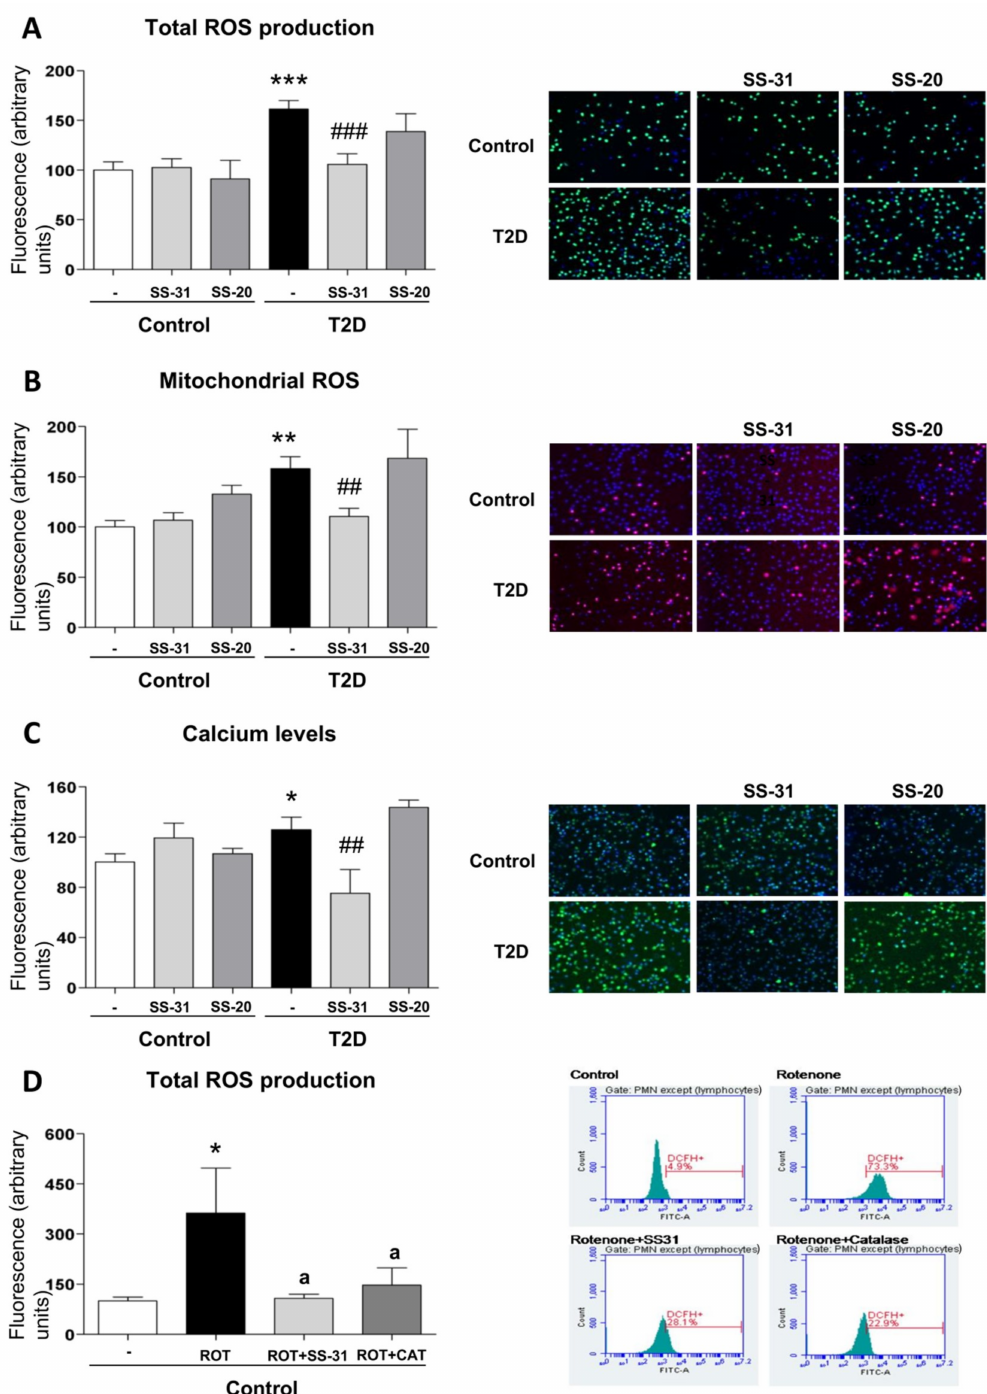
Figure 1. E ff ects of Szeto–Schiller (SS)-31 (30 min, 100 nM) on total and mitochondrial ROS production, and calcium levels in leukocytes from type 2 diabetes (T2D) patients and healthy subjects. ( A ) reactive oxygen species (ROS) production, measured as deacetylated by endogenous hydrolases to a form (DCFH)-DA fluorescence. ( B ) Mitochondrial ROS production, assessed as MitoSOX fluorescence. ( C ) Calcium levels, determined as Fluo-4 fluorescence. Representative fluorescence microscopy images are also shown. ( D ) Analysis of total ROS levels, measured as DCFH-DA fluorescence in leukocytes from healthy subjects upon a positive control treatment (rotenone, ROT) in the presence or absence of SS-31 or catalase (CAT) and representative cytograms of the 4 groups stained with APC-CD45 and DCFH-DA. 10,000 cells were analyzed in each experiment. n = 6. * p < 0.05, ** p < 0.01 and *** p < 0.001 with regard to control group; ## p < 0.01 ### p < 0.001 vs. non-treated T2D group; a p < 0.05 vs. rotenone